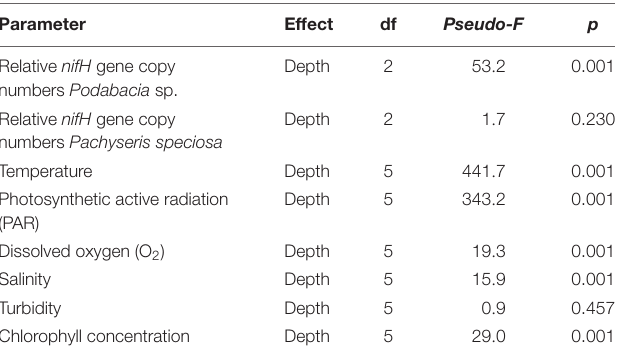
TABLE 2 | Summary of depth effects on relative nifH gene copy numbers associated with the tissues of two Red Sea coral species and for environmental factors based on permutational multivariate analysis of variance